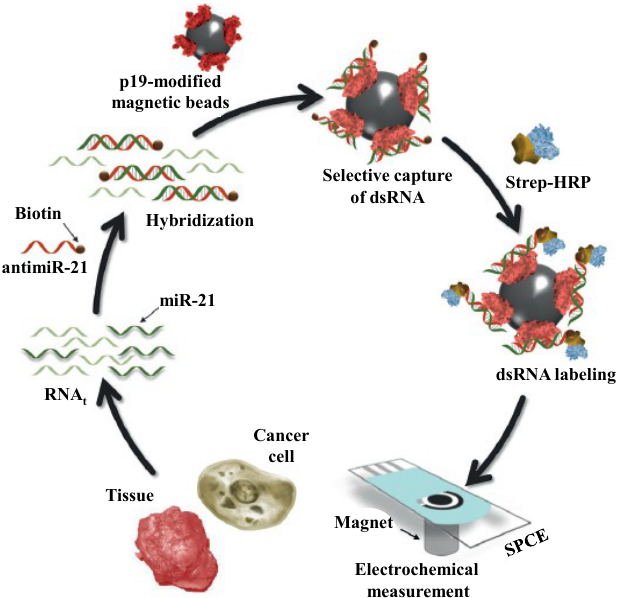
Figure 12. Schematic representation of the p19-based amperometric magnetosensor designed for the determination of miR-21. The components of the magnetosensor are not drawn to scale. Reprinted with permission from [77]. Copyright 2014 John Wiley and